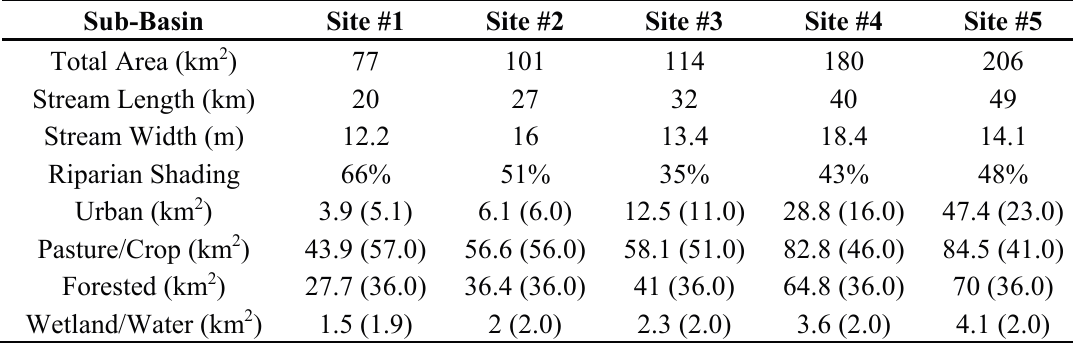
Table 1. Cumulative contributing area of sub-basins, stream length, average stream width, and land use types in Hinkson Creek Watershed. Land use areas are shown parenthetically as cumulative percent of upstream drainage area. Percent riparian shading data from Hooper